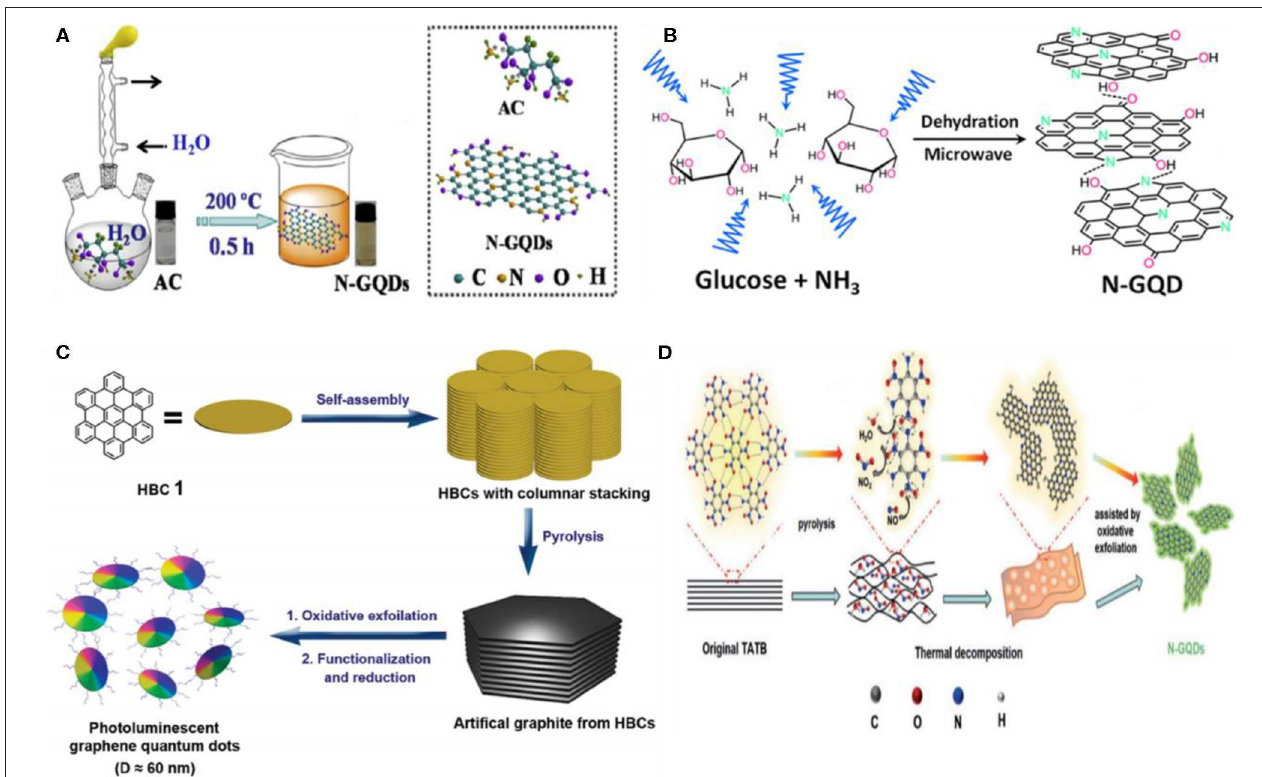
FIGURE 6 | (A) Illustration of the carbonization process for GQD formation using ammonium citrate as a precursor; reproduced from Yin et al. (2016) with permission from Elsevier. (B) Pyrolysis of glucose; reproduced from Tang et al. (2014) with permission from the American Chemical Society. (C) Pyrolysis of hexa-peri-hexabenzocoronene (HBC) for GQDs; reproduced from Liu et al. (2011) with permission from the American Chemical Society. (D) Fabrication of N-GQDs using 1,3,5-triamino-2,4,6-trinitrobenzene (TATB) precursor; reproduced from Li et al. (2016b) with permission from Wiley.